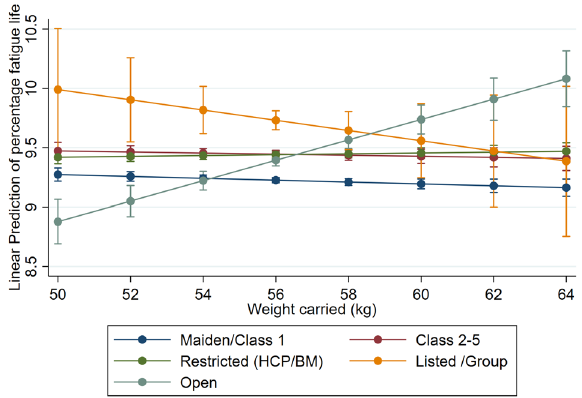
Figure 4. The interaction between weight carried and race class on the percentage of fatigue life accrued over Thoroughbred race starts in Tasmania, Australia in multivariable linear regression modelling, according to estimated joint loads scaled to a maximum of 90 MPa. *HCP/BM = Handicap/Benchmark